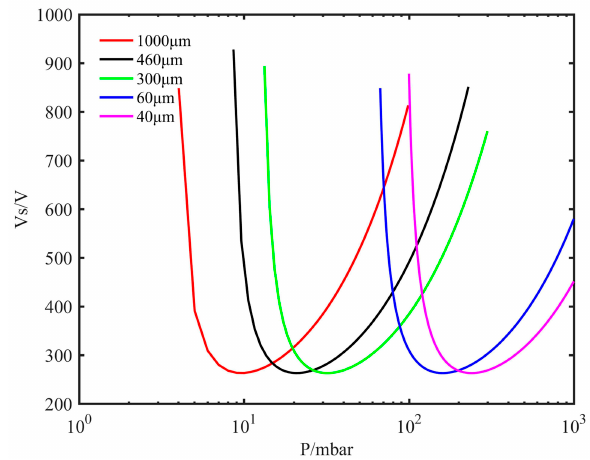
Figure 2. The Paschen curves for different distances